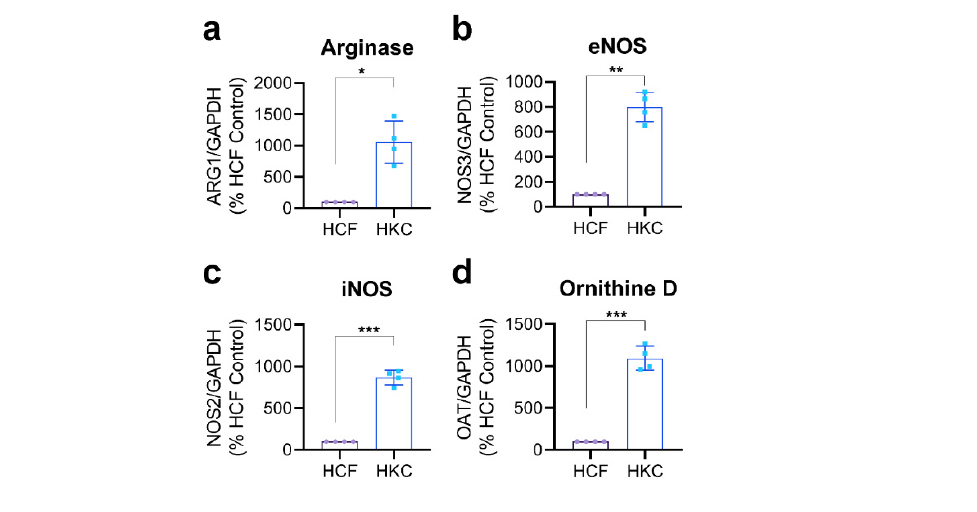
Figure 3. Gene expression patterns of arginine-related enzymes in HCFs and HKCs. Relative transcript levels of ( a ) arginase, ( b ) eNOS, ( c ) iNOS, and ( d ) ornithine D assessed by RT-PCR. Values shown as normalized to the housekeeping gene (GAPDH) and relative to HCF control levels. Statistical significance assessed using an unpaired, nonparametric t -test with Welch’s corrections with * p < 0.05, ** p < 0.01, and *** p < 0.001 based on n = 4. Error bars represent standard deviation.